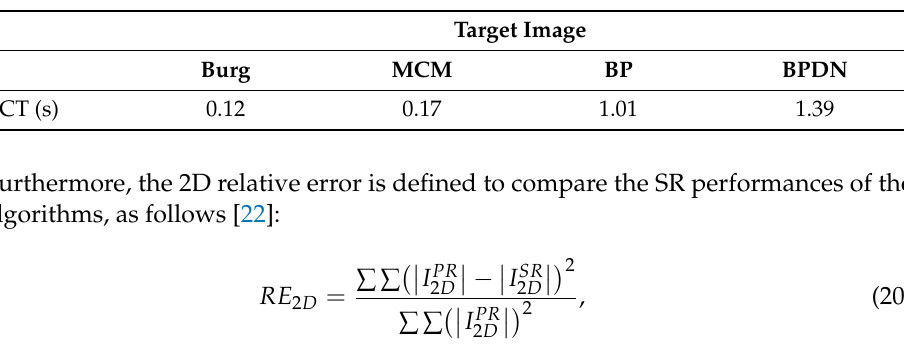
Table 6. CTs for super-resolved target images of extended moving target.